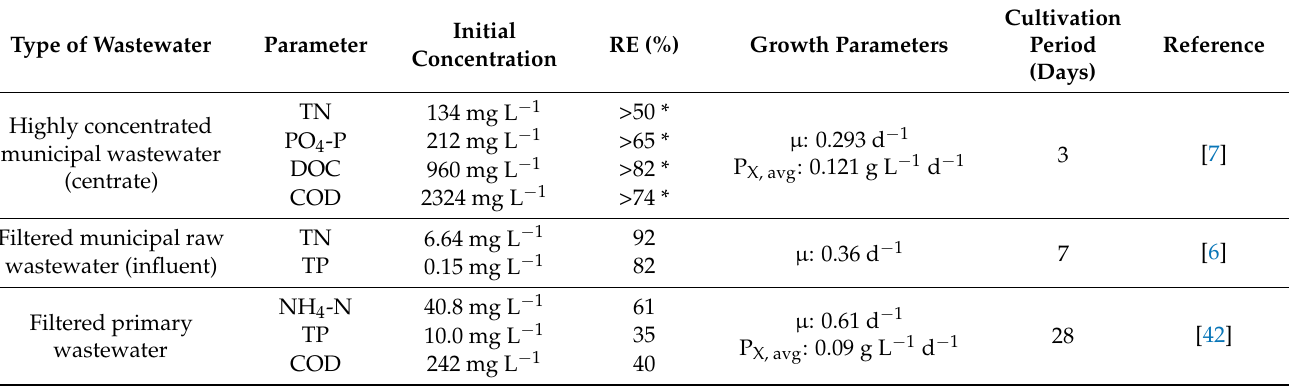
Table 3. Comparison between growth parameters and removal efficiencies of nitrogen (N), phospho- rus (P), and organic matter (TDC and COD) obtained in this study and other studies focusing on real wastewater treatment using Chlorella vulgaris